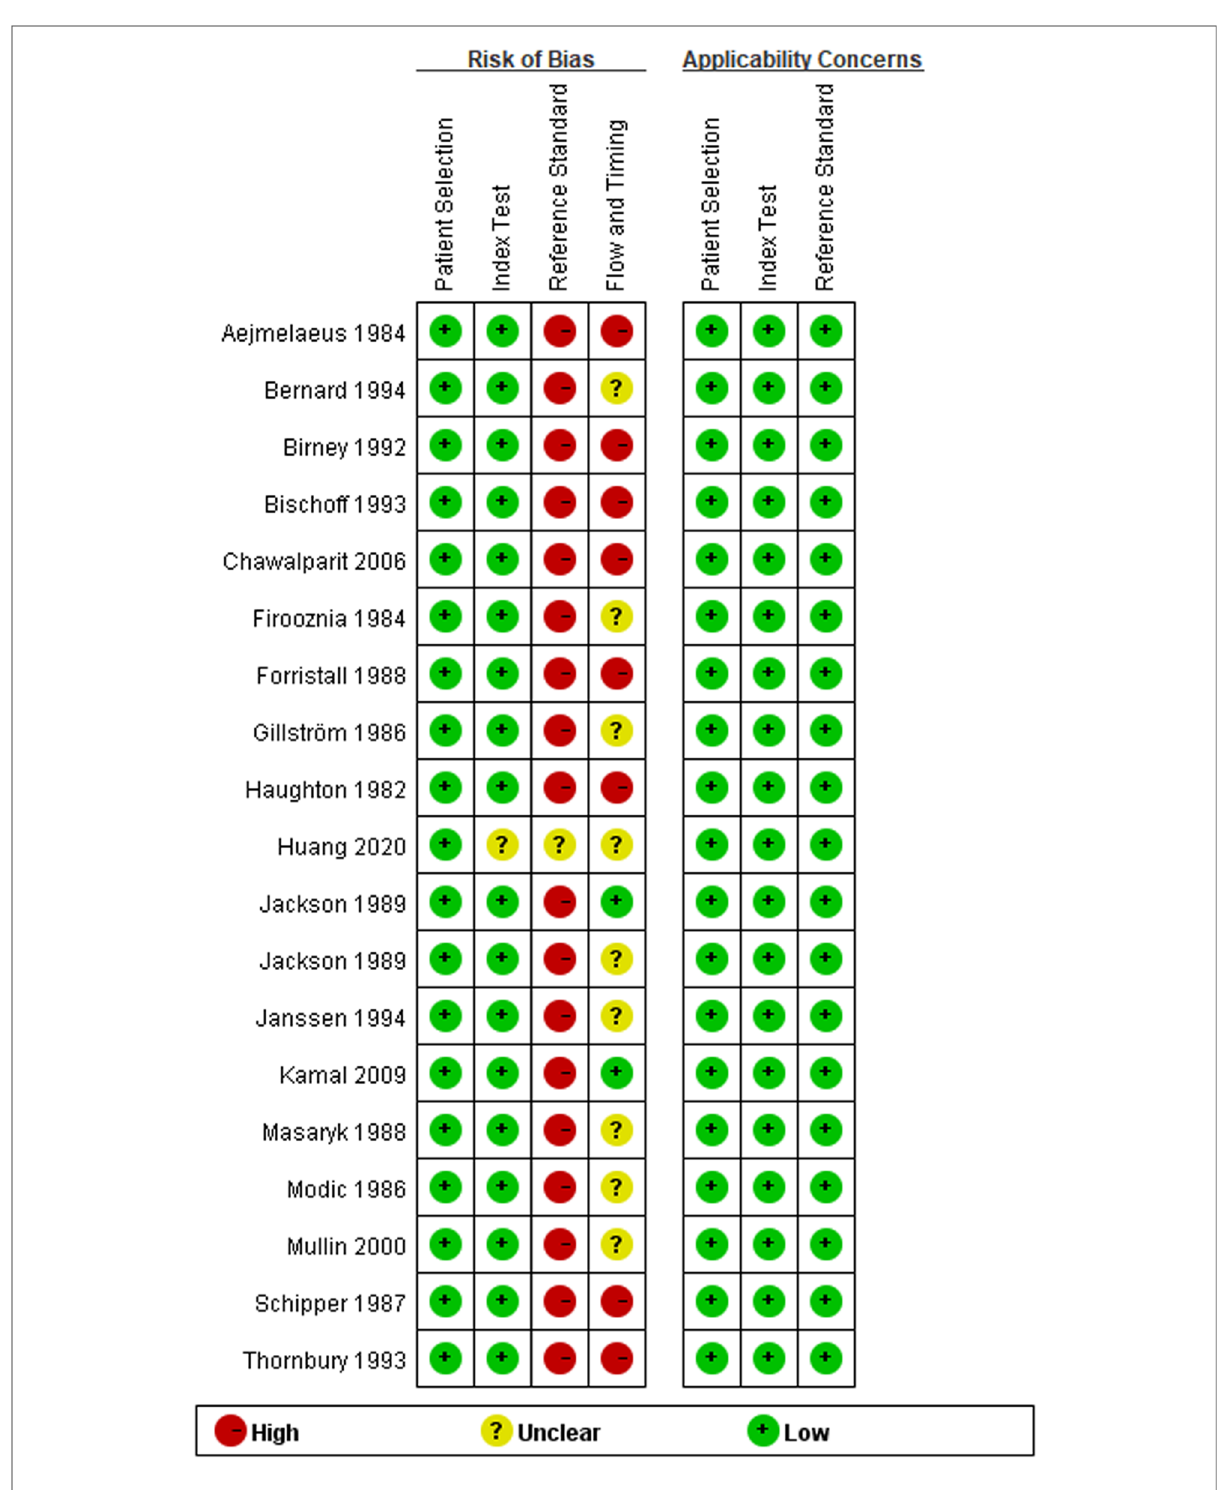
Figure 3 Risk of bias and applicability concerns